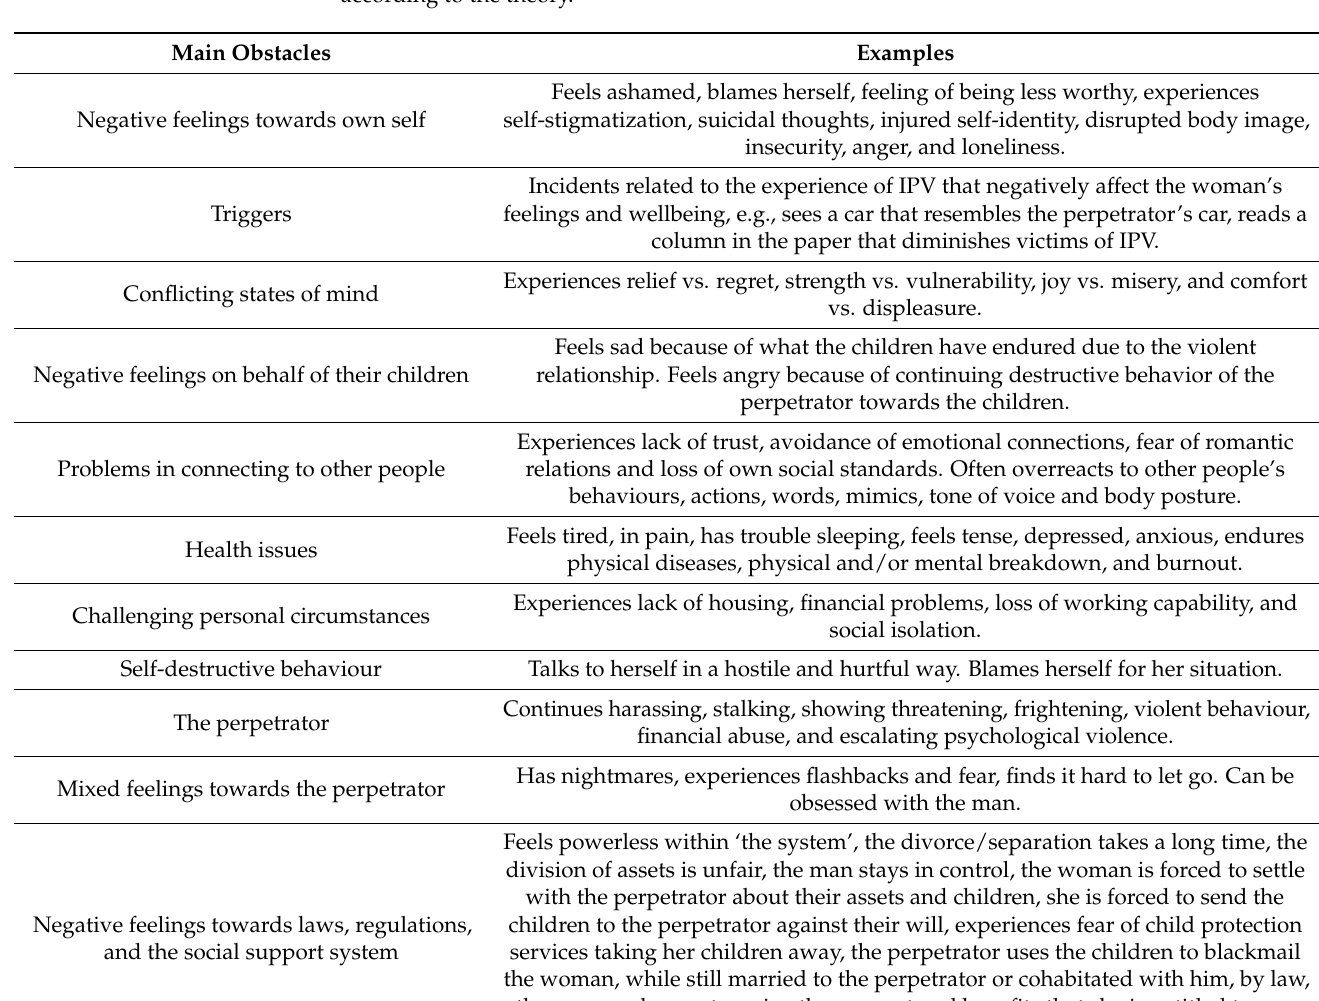
Table 8. Component 5: Overview of the main obstacles on the women’s PTG journey following IPV according to the